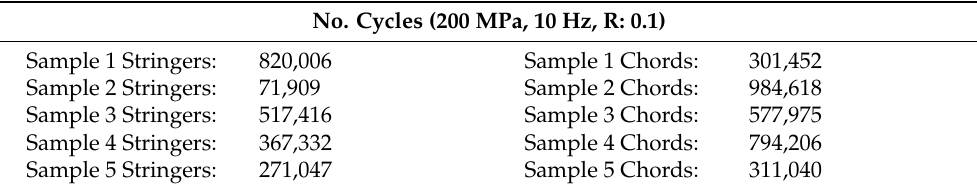
Table 4. Results Corbones: number of cycles under fatigue dynamic test (10 Hz, R:0.1).